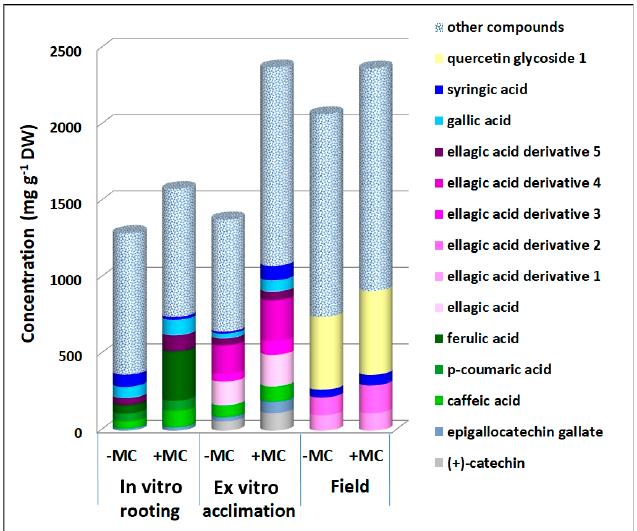
Figure 4. Concentrations of phenolic compounds in the aboveground part of strawberry cv. ‘Solnechnaya polyanka’ plants contributed to the increase in the total phenolic content under the influence of the MC during in vitro rooting, ex vitro acclimation, and field growth. Abbreviations: MC, mechanocomposite; − MC, mechanocomposite free; +MC, mechanocomposite treatment; DW, dry weight.